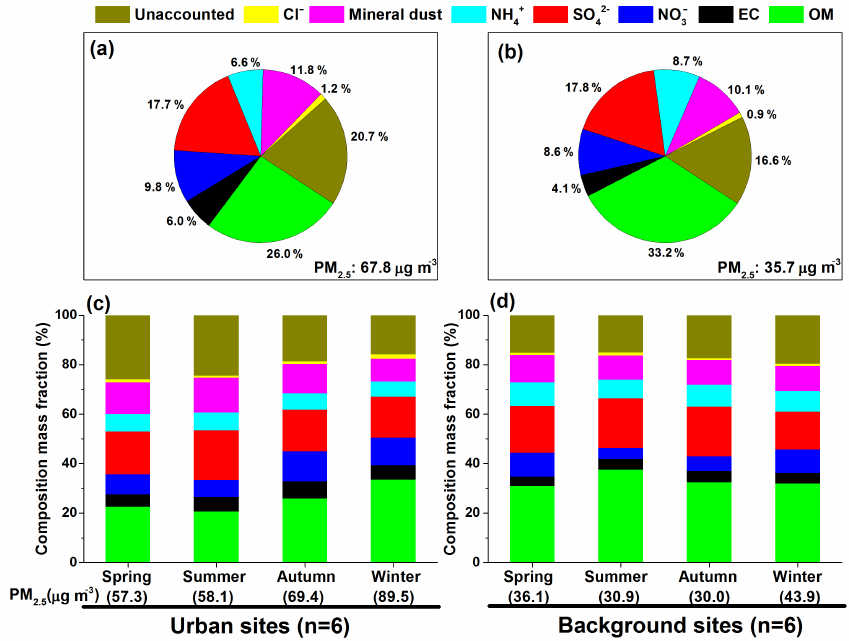
Figure 4. Average chemical composition and its seasonal variations of PM 2 . 5 at (a, c) urban sites and (b, d) background sites. The unac- counted matter refers to the difference between the PM 2 . 5 gravimetric mass and the sum of the PM constituents (OM, EC, SO 2 − NH + ,Mineral dust and Cl − 4